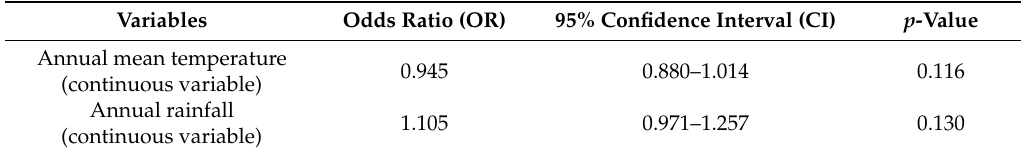
Table 5. Possible risk factors associated with higher Neospora caninum prevalence in goat farms using univariate analysis.